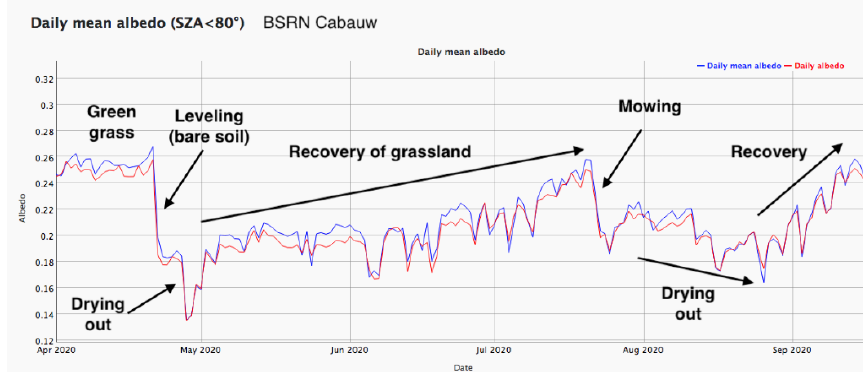
Figure 9. The daily mean albedo on BRSN CAB site (courtesy of Dr. Wouter Knap [41]). The Δ LST also shows a seasonal variation over the CAB site where a cold bias dis- plays in the daytime while a warm bias displays in the nighttime in the summer. The LST error over the GOB site does not show an obvious seasonal signal, except for a minor bias variation to a very small extent, i.e., a warm bias in January to March and then a change to a slight cold bias from April to July.